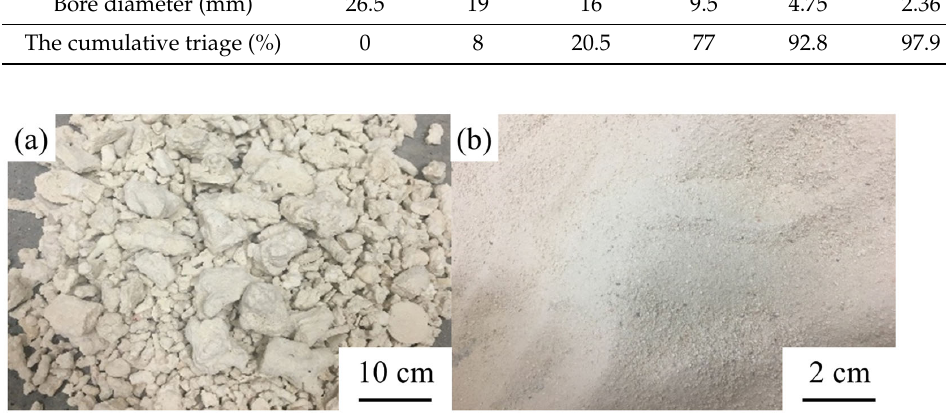
Table 2. Accumulated retained percentage of coarse coral aggregate.